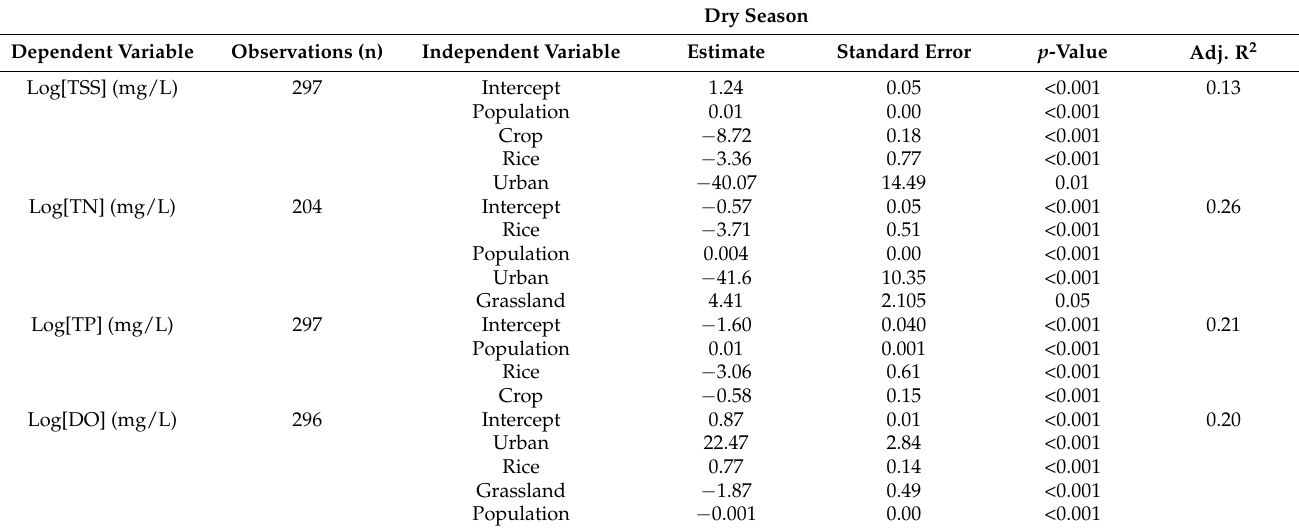
Figure 2. Land use changes in study watersheds of Cambodia, Laos, Thailand, and Vietnam from 2000 to 2017. Note that y axes differ among panels. Table 1. Multiple regression models with anthropogenic drivers in the dry